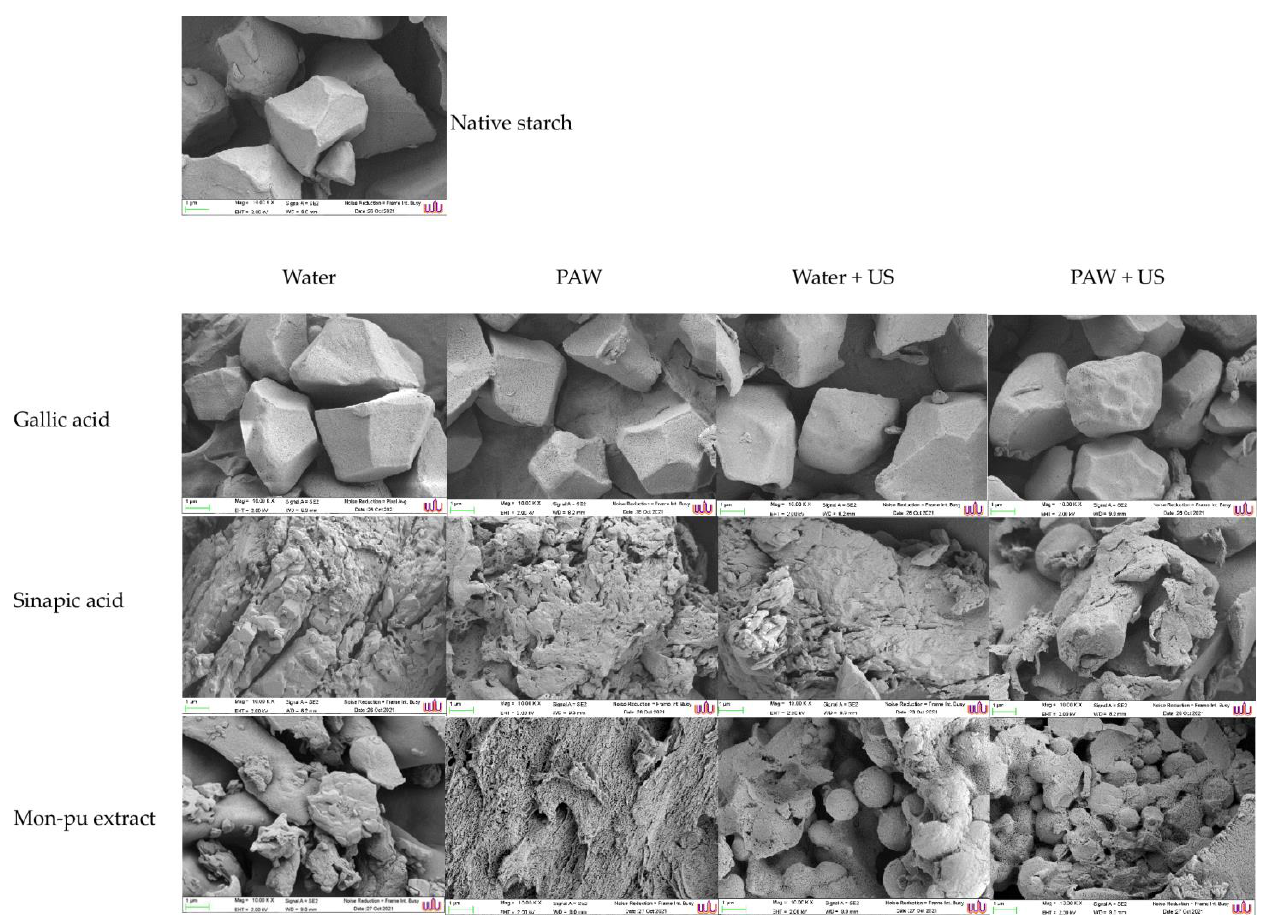
Figure 5. Scanning electron microscopic (SEM) images of rice starch–phenolic complexes. Different phenolic compounds—gallic acid, sinapic acid, and crude Mon-pu ( Glochidion wallichianum Muell Arg) extract—were complexed with hydrothermally pre-gelatinized rice starch prepared using distilled water (Water) or plasma-activated water (PAW) without and with the aid of ultrasonication (+US). The native starch was used to compare. EHT: 2.0 kV. Magnification: 10,000 ×